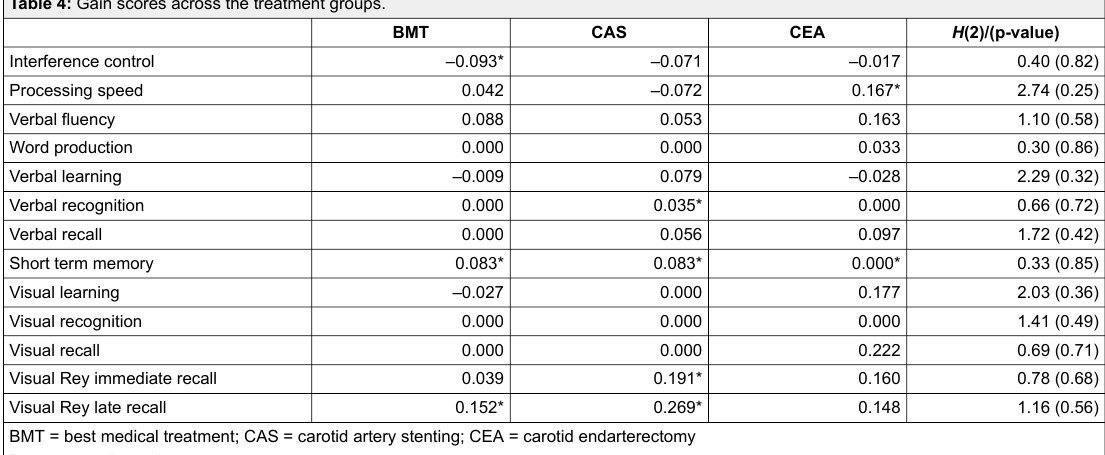
Table 4: Gain scores across the treatment